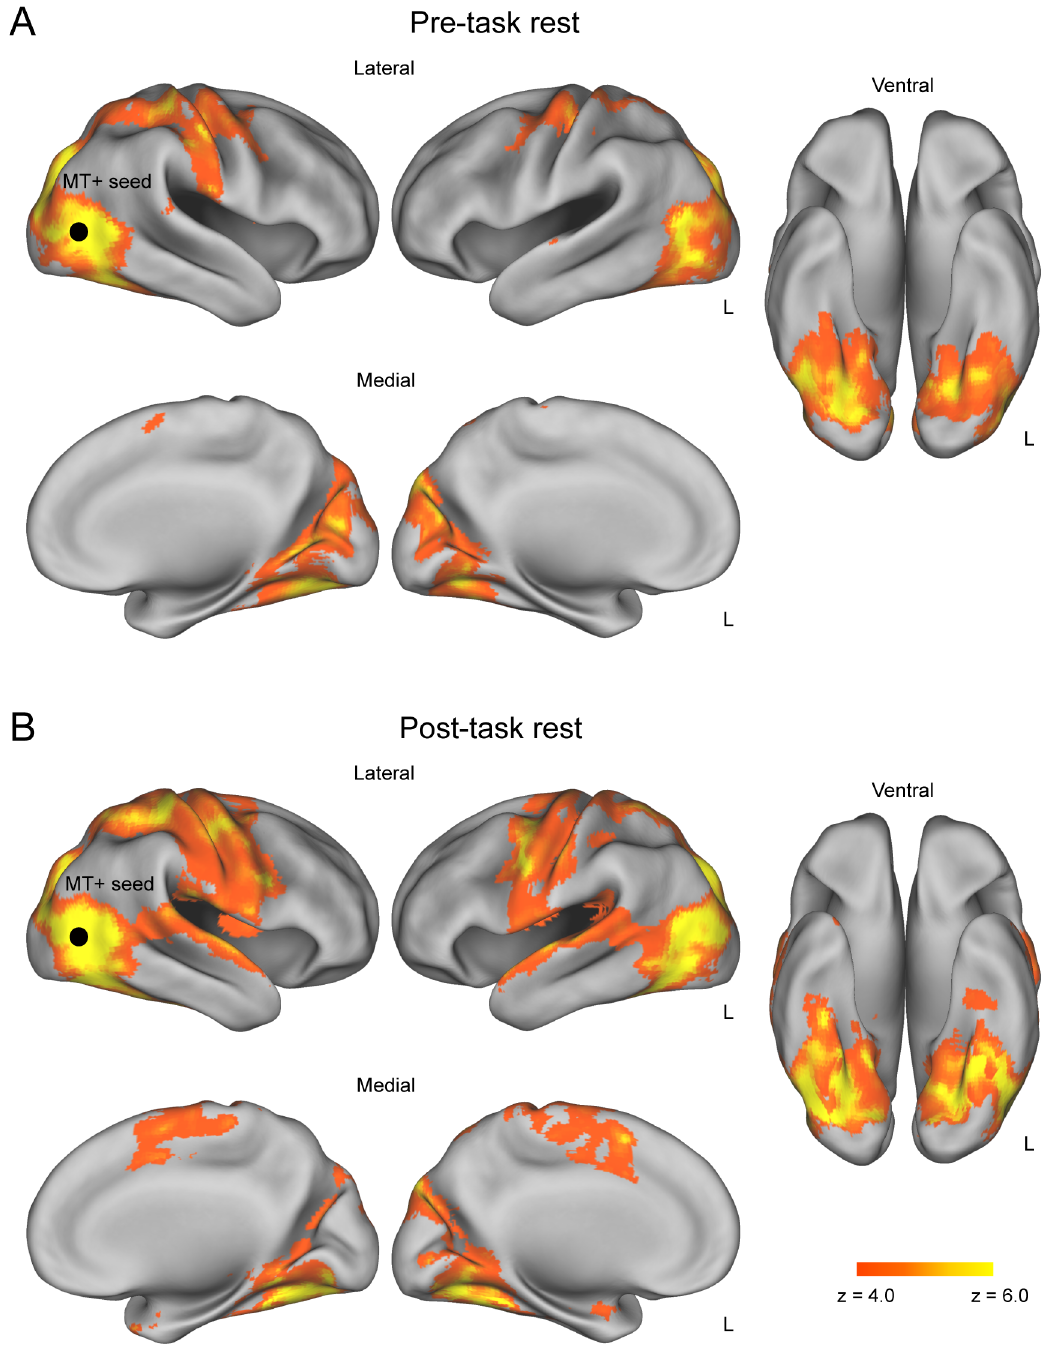
Fig 3. Resting-state functional connectivity with MT+ seed. (A) Pre-task rs-FC maps indicating areas that showed significant rs- FC with the MT+ before participants performed the motion discrimination task. (B) Post-task rs-FC maps indicating areas that showed significant rs-FC with the MT+ after participants performed the motion discrimination task. All maps are thresholded at P < 0.05, cluster-level FWE corrected across the whole brain. Black circle: approximate location of the MT+